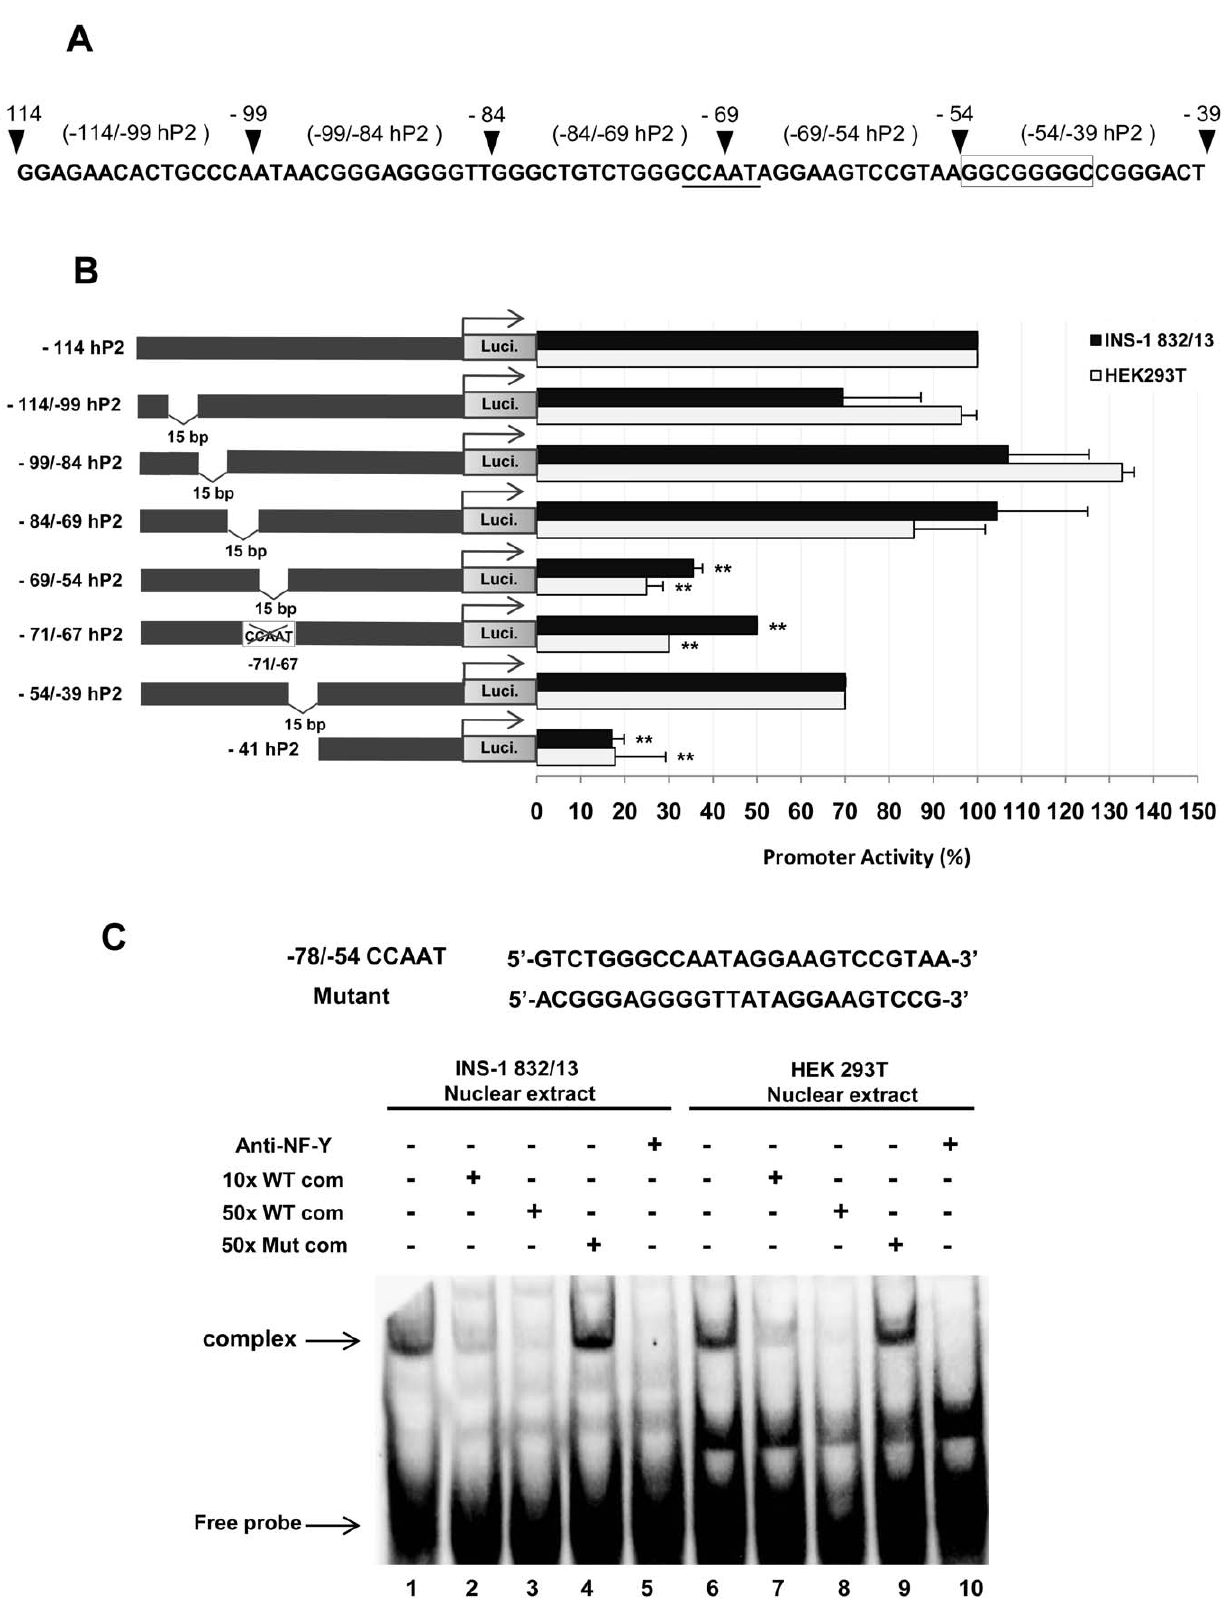
Figure 4. Identification of positive regulatory element(s) located between 2 114 and 2 39 of the human PC P2 promoter. (A) Schematic diagram of 15 bp internal deletions of 2 114/ 2 39 of the human PC P2 promoter. (B) Transient transfections of a series of 15 bp internal deletion constructs into the INS-1 832/13 and non-beta cell HEK293T cell lines were performed to localize the positive regulatory sequence in the